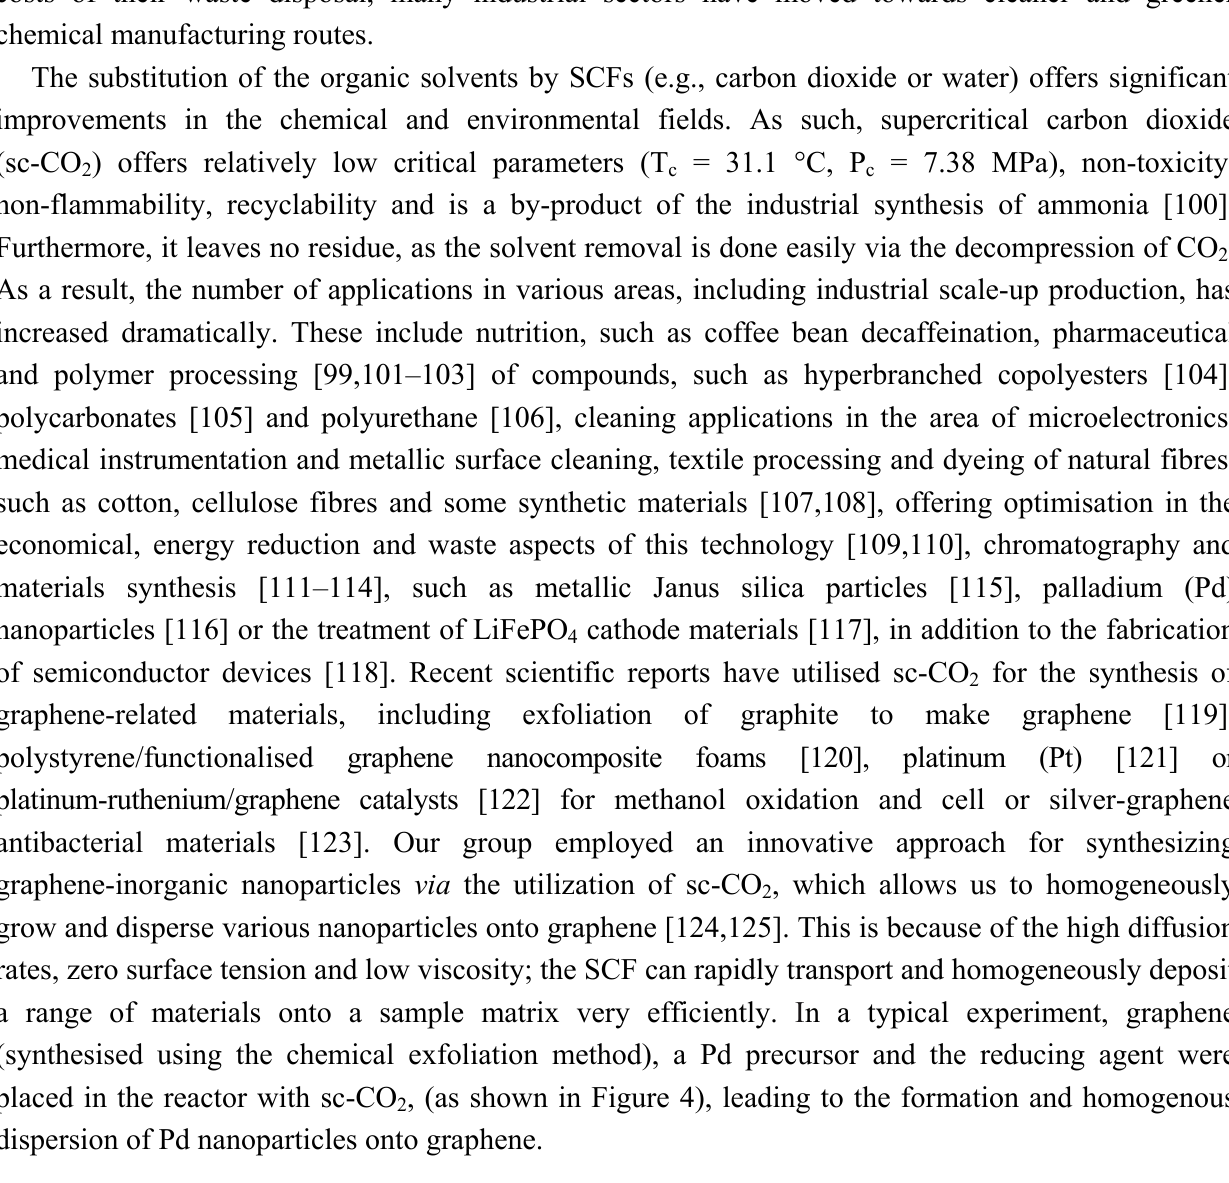
Figure 4. A schematic representation for the synthesis of Pd-graphene nanocomposites using sc-CO 2